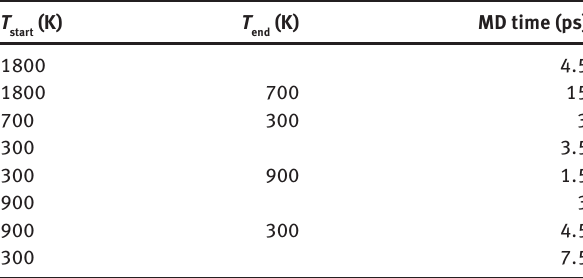
Table 1: Thermal processes to generate annealed a-Si sample equilibrated at T = 300